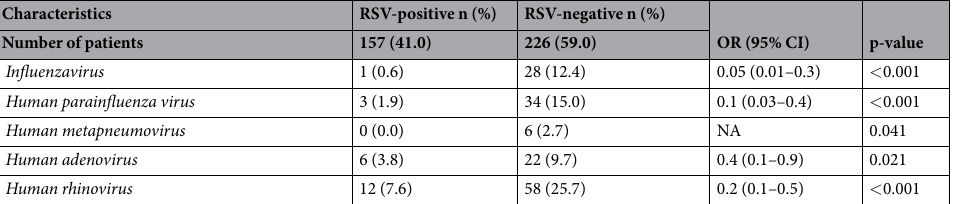
nia (Table 2, Supplemental data Table S2). Influenzavirus , Human parainfluenza virus , Human metapneumovirus , Human adenovirus , and Human rhinovirus